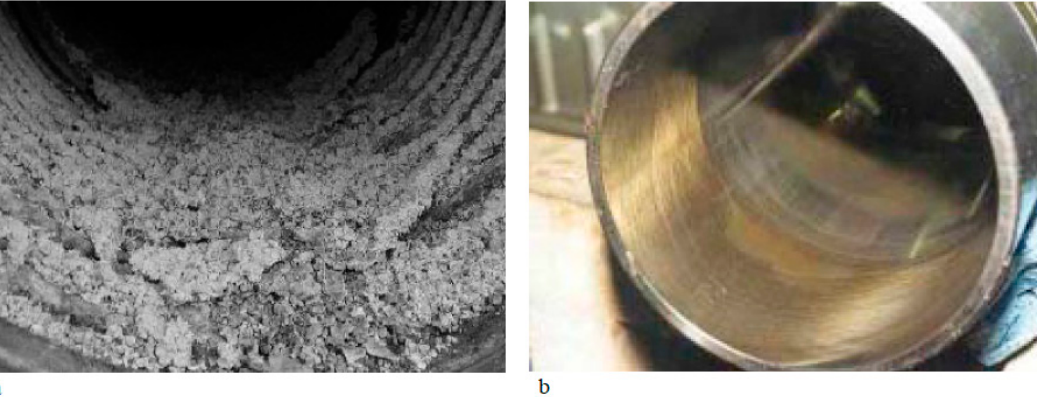
Figure 5. Sample results of the videoscopic observations of combustion chambers: ( a ) siloxane layer on the inner surfaces of a cylinder piston and piston liner and ( b ) sulphur deposits in the gas engine [38].